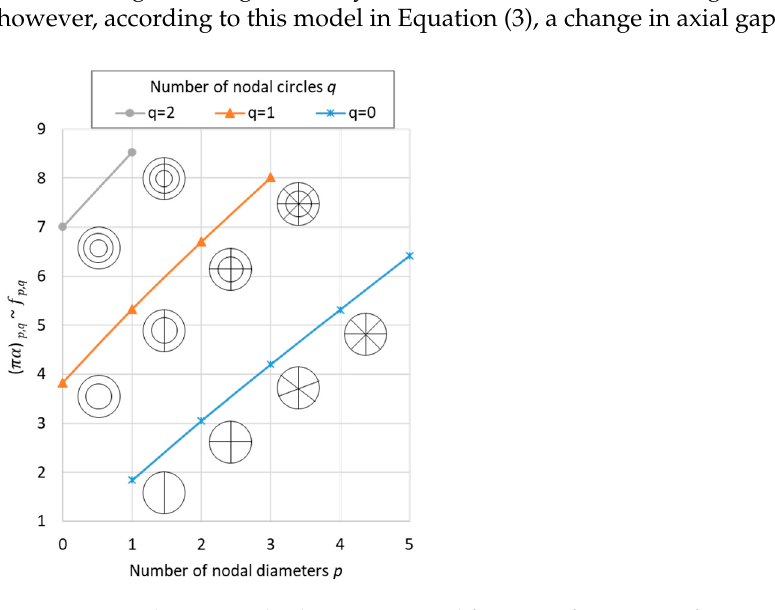
Figure 1. Non-dimensional solutions to Bessel functions for acoustic frequencies inside a cylinder and respective mode shapes for different numbers of nodal diameters and nodal circles.